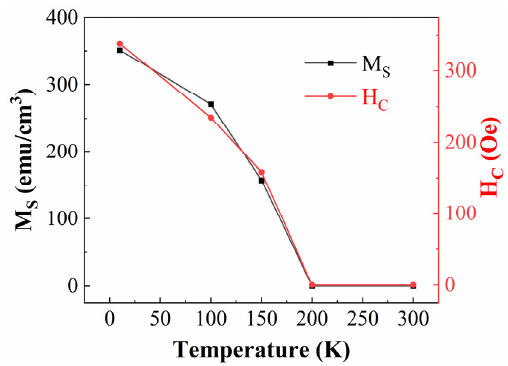
Figure 5. The temperature dependence of saturation magnetization M S and coercive field H C for the PSMO film on SrTiO 3 . Note: the solid lines guide the eyes to see.